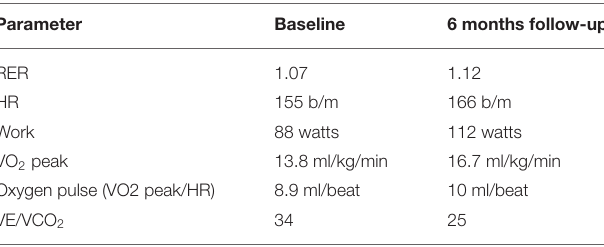
TABLE 3 | Comparison on cardiopulmonary exercise test derived data between baseline and 6 months follow-up. Parameter